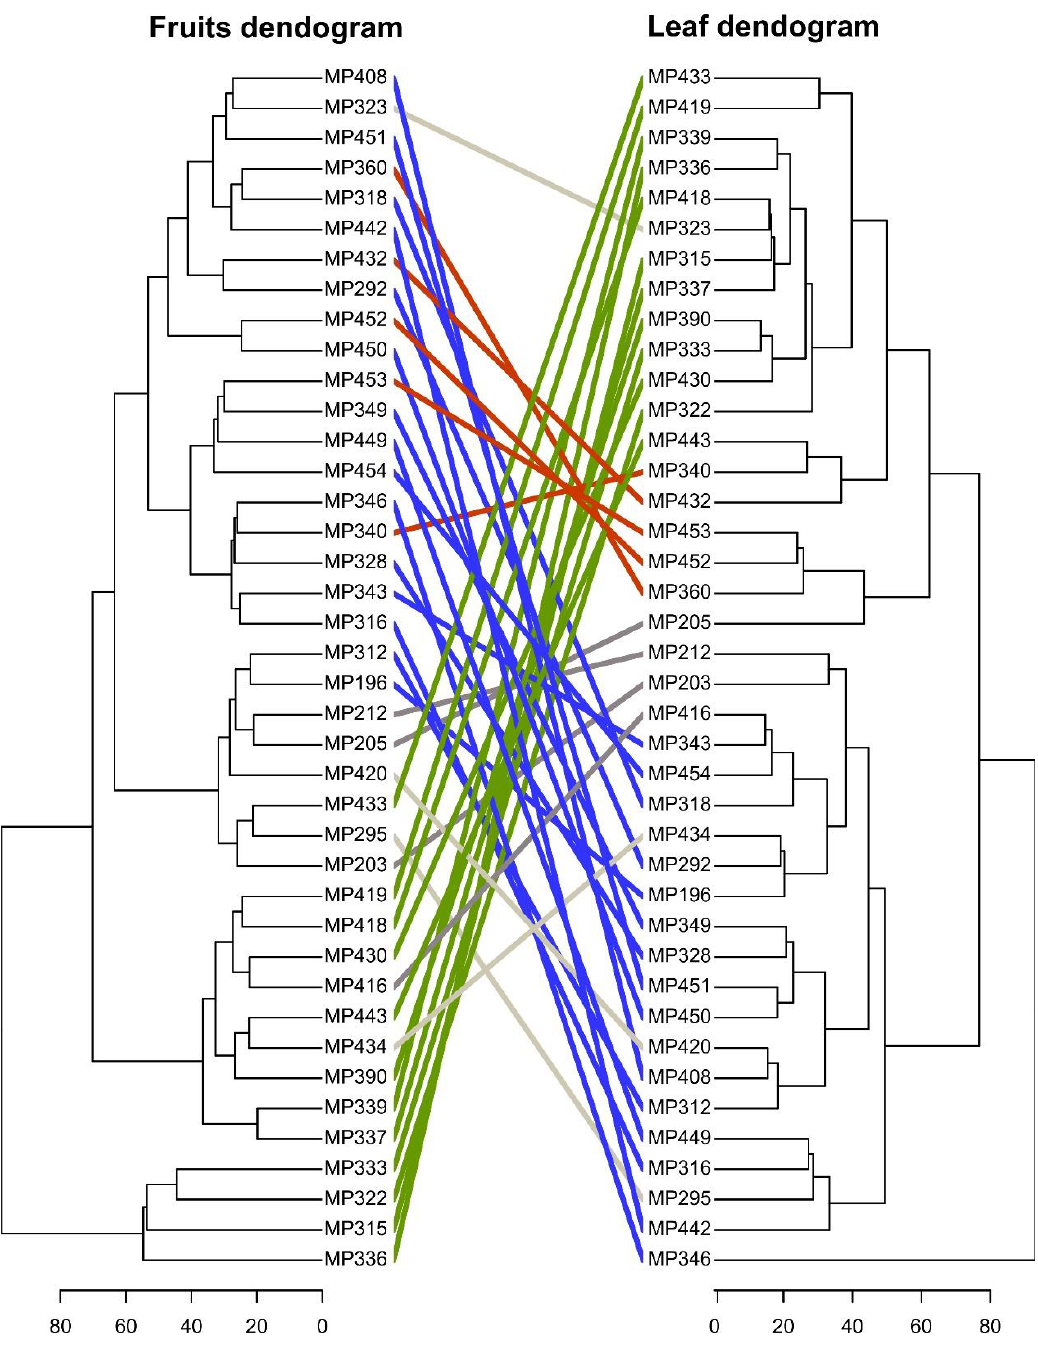
Figure 1. The tanglegram compares the hierarchical clustering of mother plants employing fruits versus leaves metabolite profiles. Individual dendrograms were calculated using hierarchical clustering with the ward.D2 method. The signal intensity of every peak mass used for generation of dendrograms consisted of the average of three technical replicates.